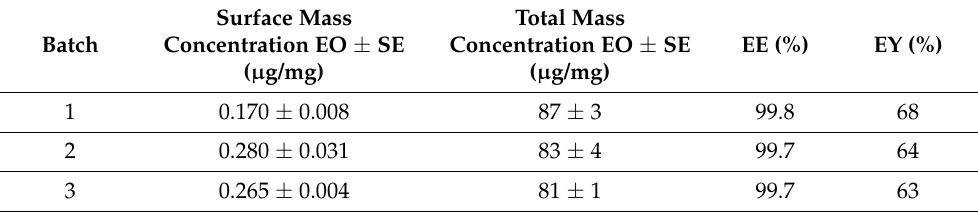
Table 1. Determination of total catnip essential oil (EO) concentration extracted from the inclusion complex and concentration of catnip essential oil recovered from inclusion complex surface, with associated standard error (SE). Report of encapsulation efficiency (EE) and encapsulation yield (EY). Analyses were performed by GC-FID. n = 3.